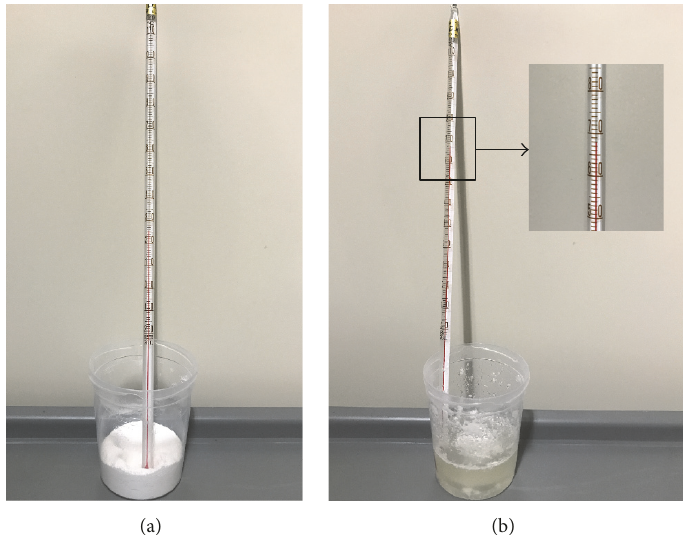
Figure 4: Exothermic reaction of Picolight (cid:2) powder. (a) A pack of Picolight powder in a plastic container. The temperature of the powder was 25 ∘ C. (b) The temperature was measured immediately after mixing the Picolight powder with 30 cc of water. The temperature rose to 68 ∘